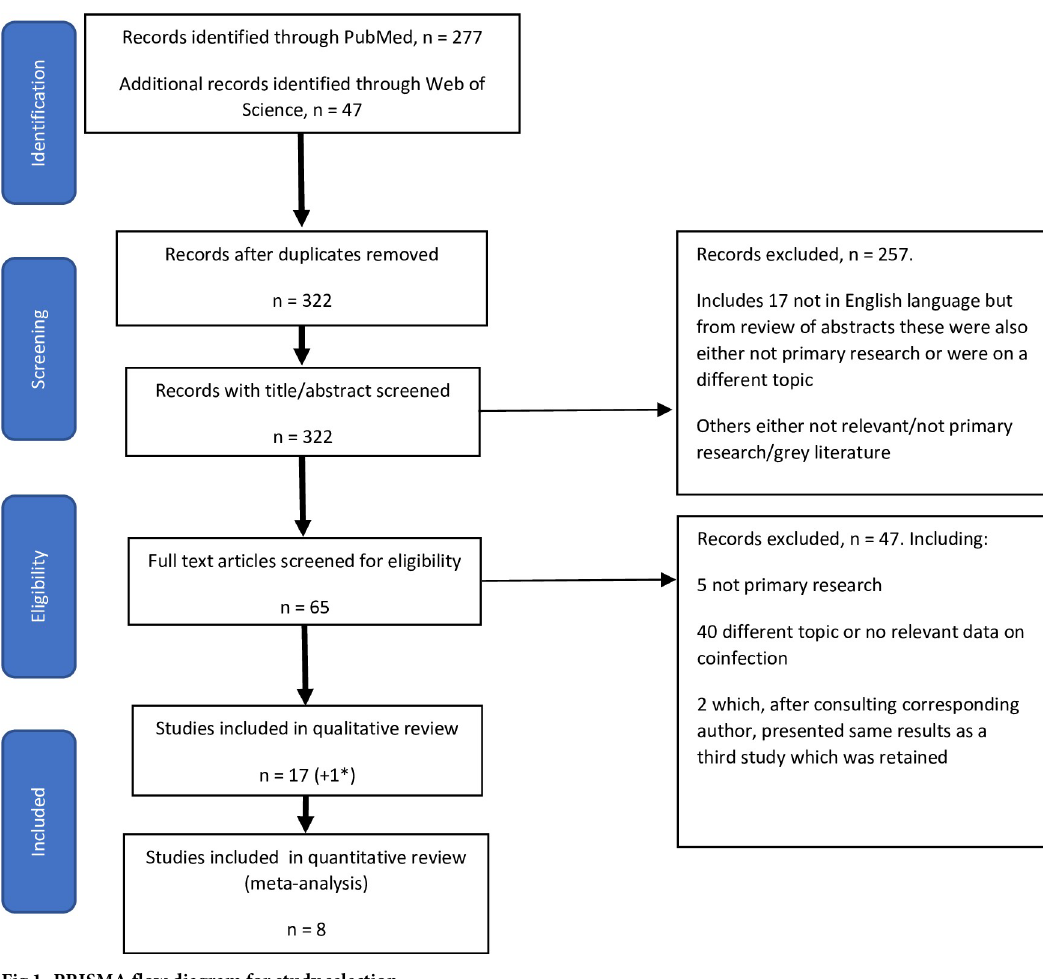
Fig 1. PRISMA flow diagram for study